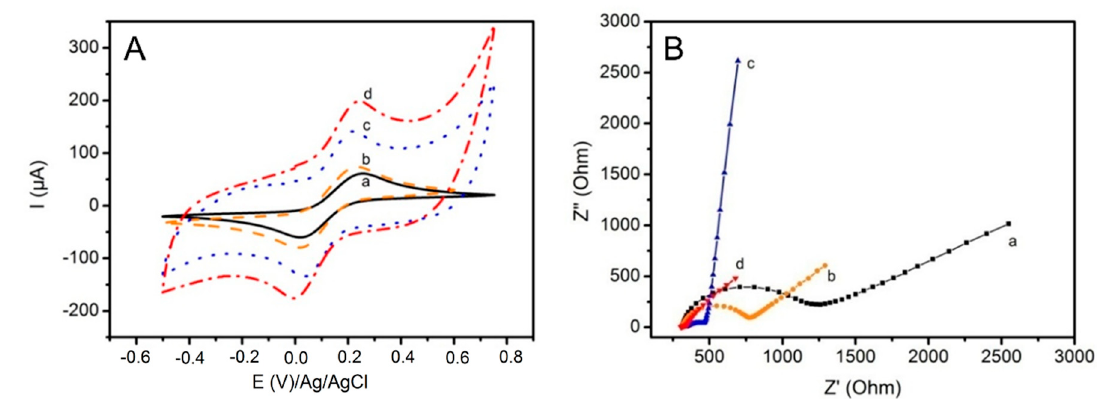
Figure 3. Electrochemical characterization in solution of 5 mM [Fe(CN)6] 3/4 − , 0.1 M KCl solution. ( A ) CV obtained with scan rate 100 mV/s and ( B ) EIS obtained with frequency range: 100 KHz to 0.1 Hz ( a ) SPCE, ( b ) SPCE/MoS2, ( c ) SPCE/PPyNPs, and ( d ) SPCE/MoS2/PPyNPs.